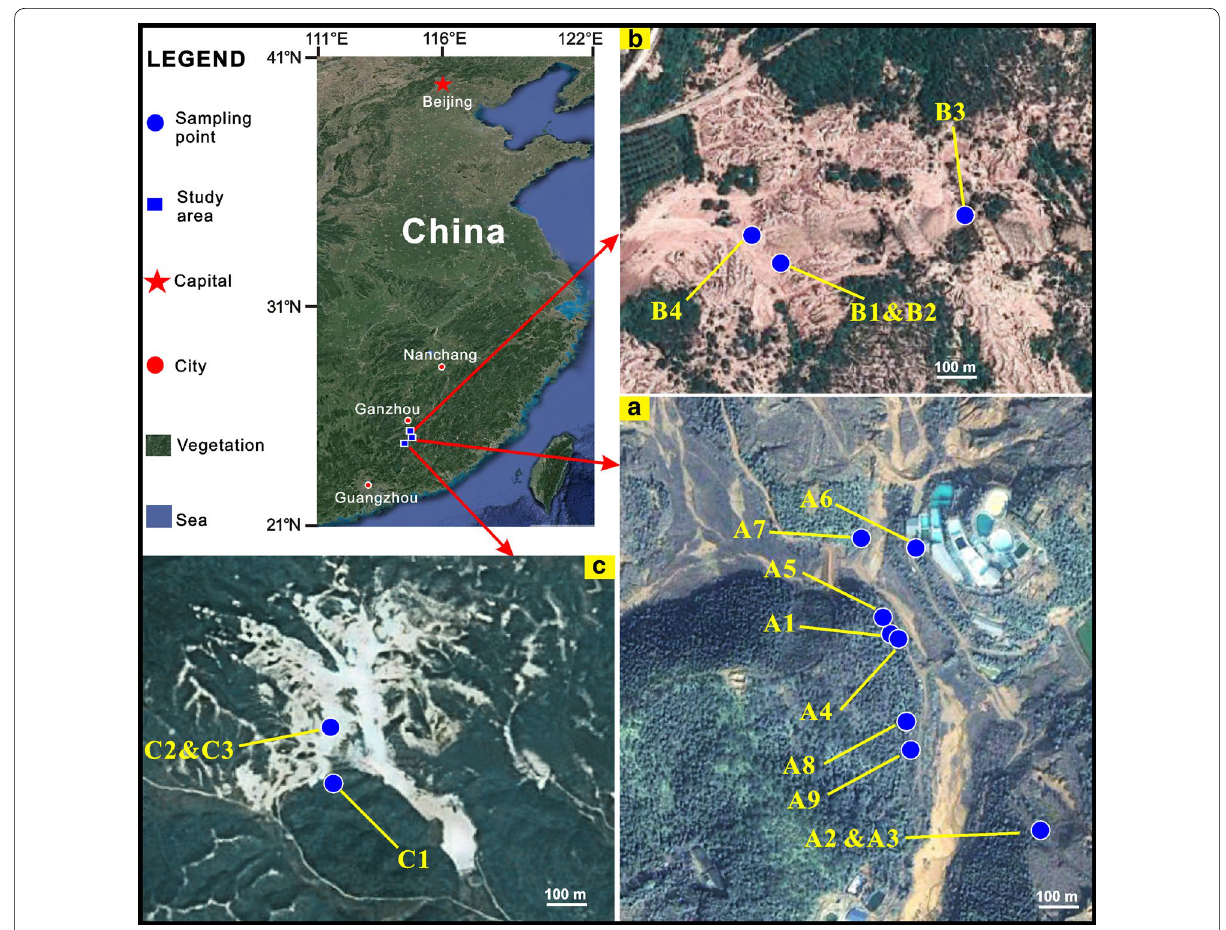
Fig. 1 Remote sensing images of three rare‑earth‑element mines in southern Jiangxi, China. The geomorphologic features and 16 sampling sites ( blue circles ) are shown in the